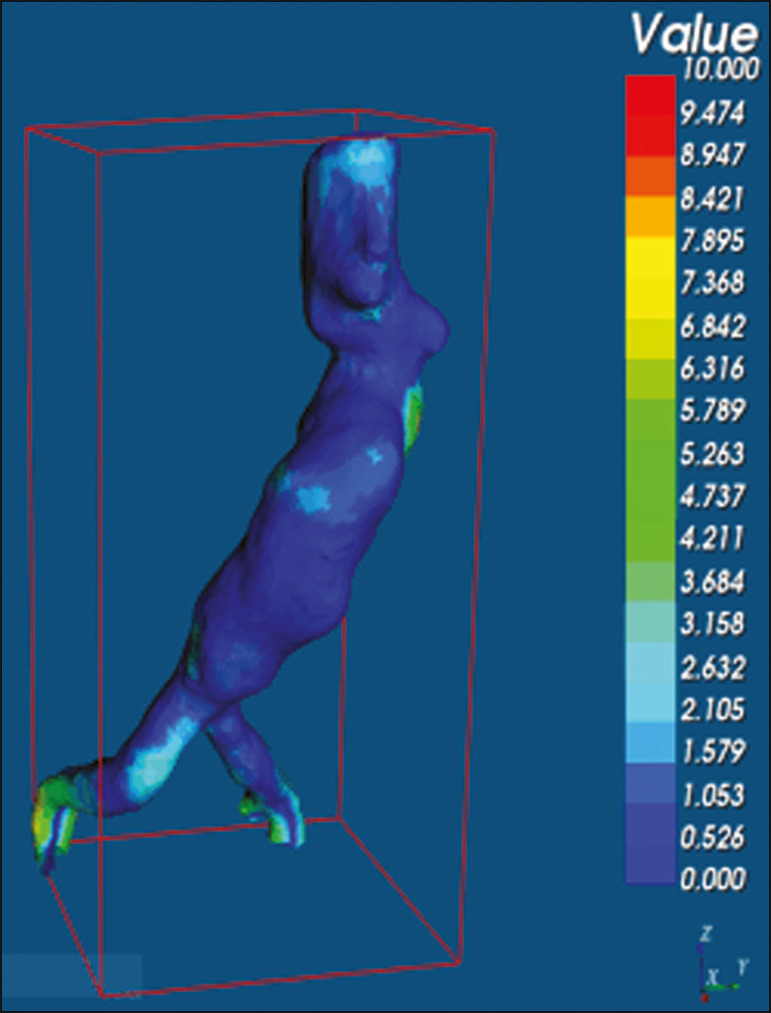
Anterior view of the model and analysis of the differences between the distances, represented in a range of colors, with the VRMesh software.